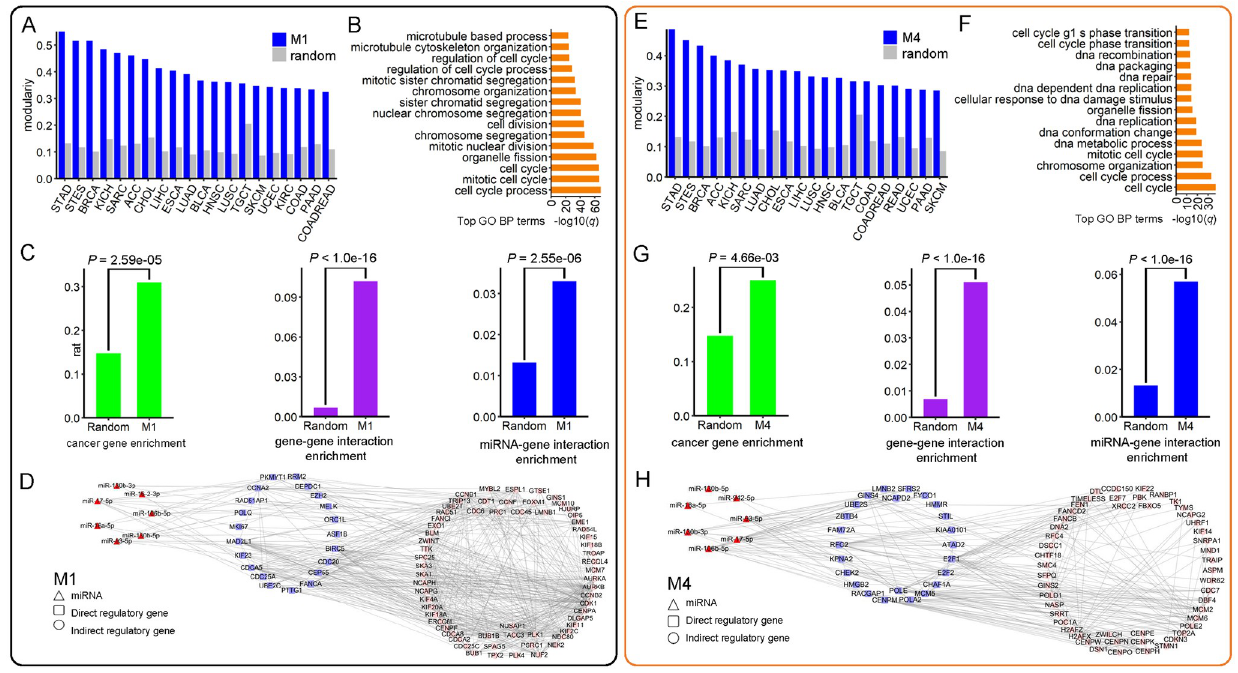
Fig 5. Illustration of two cancer-miRNA-gene modules identified by TSCCA in the TCGA dataset. The results on module 1 are shown in (A), (B), (C) and (D), while the results on module 4 are shown in (E), (F), (G) and (H). (A) Bar plot showing modularity scores of module 1 and a random one for different cancer types. (B) Top enriched GO BP terms on the genes within module 1. (C) Cancer gene enrichment, gene-gene interaction enrichment and miRNA-gene interaction enrichment of module 1 and the corresponding P -values were computed using the right-tailed hypergeometric test. (D) Largest connected miRNA-gene subnetwork of module 1 (including 7 miRNAs and 84 genes and 538 edges), where the miRNAs directly regulate 21 genes and the 21 genes regulate 63 other genes. Similar setting was used for module 4 in (E), (F), (G) and (H). (H) Largest connected miRNA-gene subnetwork of module 4 (including 7 miRNAs and 75 genes and 309 edges), where the miRNAs directly regulate 24 genes and the 24 genes regulate 51 other genes.